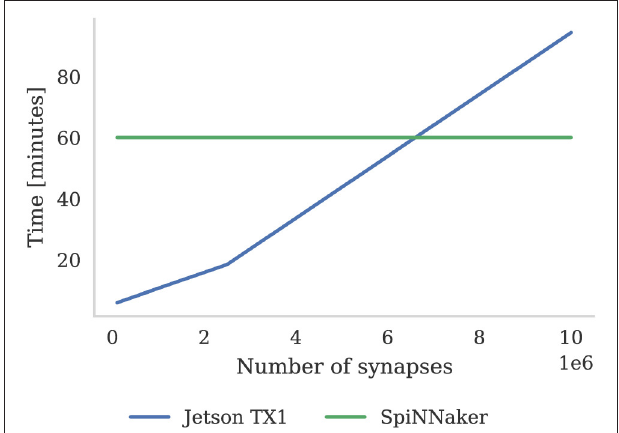
FIGURE 8 | Time to simulate 1h of the Pavlovian conditioning experiment described in section 3.2 at three different scales. SpiNNaker can simulate all configurations in real-time. The Jetson TX1 GPU and all CPUs are set to run at the maximum supported